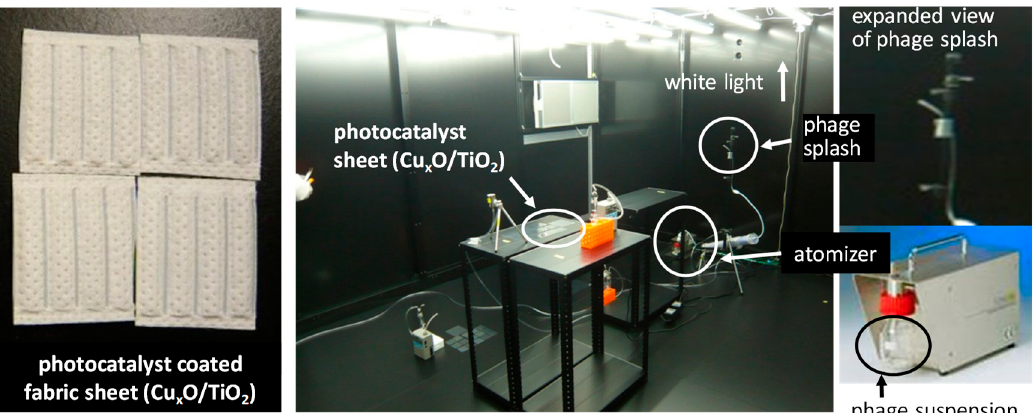
Figure 16. Procedure for evaluating an antiviral Cu x O / TiO 2 -coated fabric sheet using pseudo splash-containing bacteriophage Q β . Room volume was (4 m × 3 m × 2 m) and the ventilation frequency was 1.8 time / h. White light was irradiated by fluorescent lightbulbs at an illuminance of 1000 lux. Bacteriophage Q β containing 6 × 10 7 pfu / h was sprayed for 4 h by an atomizer (ATM-226, KANOMAX JAPAN INC.) to attach it on the sheet surfaces.